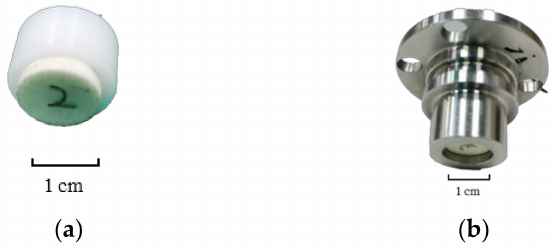
Figure 4. Home-made air-coupled transducer ( a ) without pre-tightening; ( b ) with